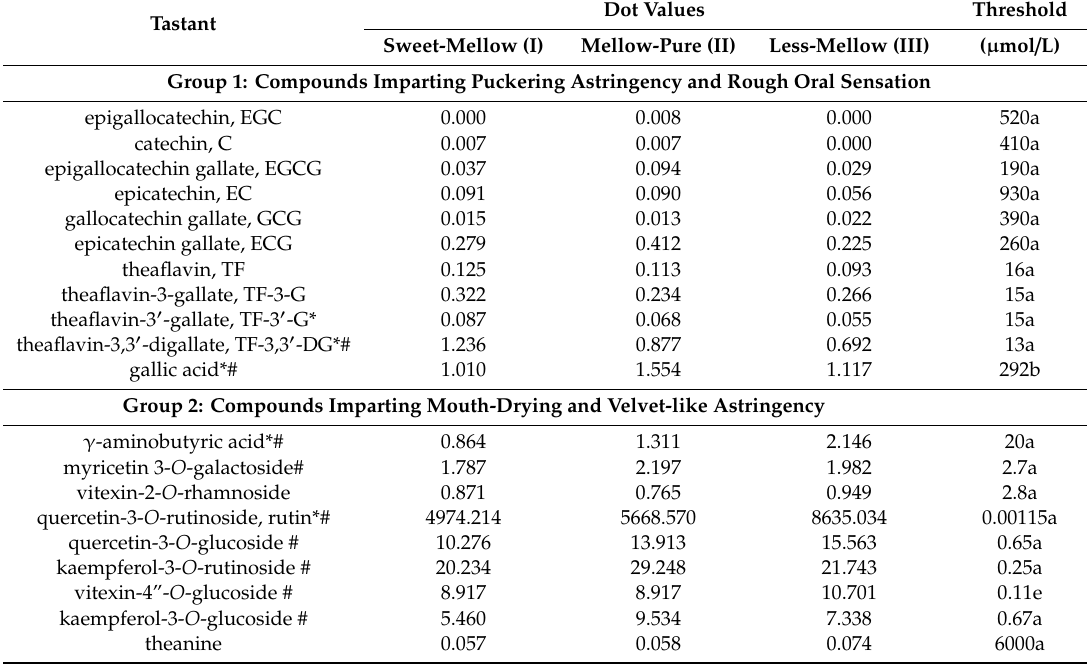
Table 3. Taste contribution of tea components in the sweet-mellow (I), mellow-pure (II), and less-mellow (III) black tea infusions, evaluated by dose-over-threshold (Dot) factors, which are calculated as the ratio of the concentration of each compound in tea infusion to its corresponding taste threshold. Data presented is mean value of Dot factors ( n = 11, 14, and 8,